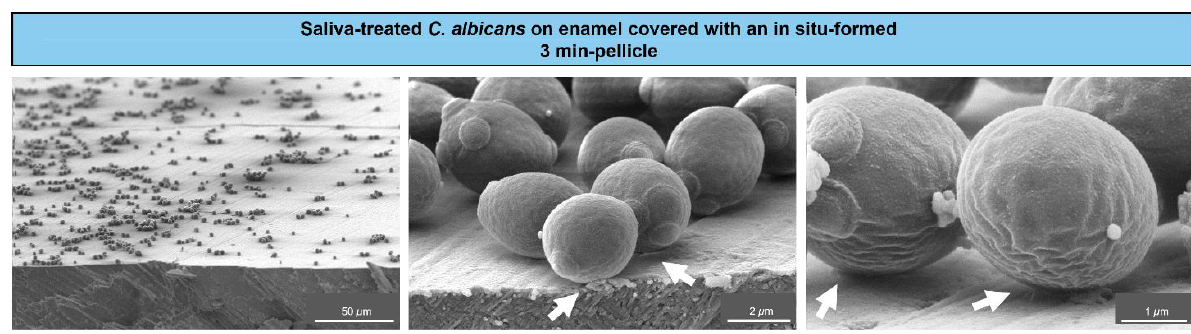
Figure 1. Scanning electron microscopy of C. albicans colonizing tooth enamel. Representative micrographs of C. albicans yeast cells from a liquid growth culture and after saliva treatment, which were left to adhere on tooth enamel covered with an in situ-formed 3 min-pellicle. Arrows indicate the contact sites between the cells and the salivary pellicle.